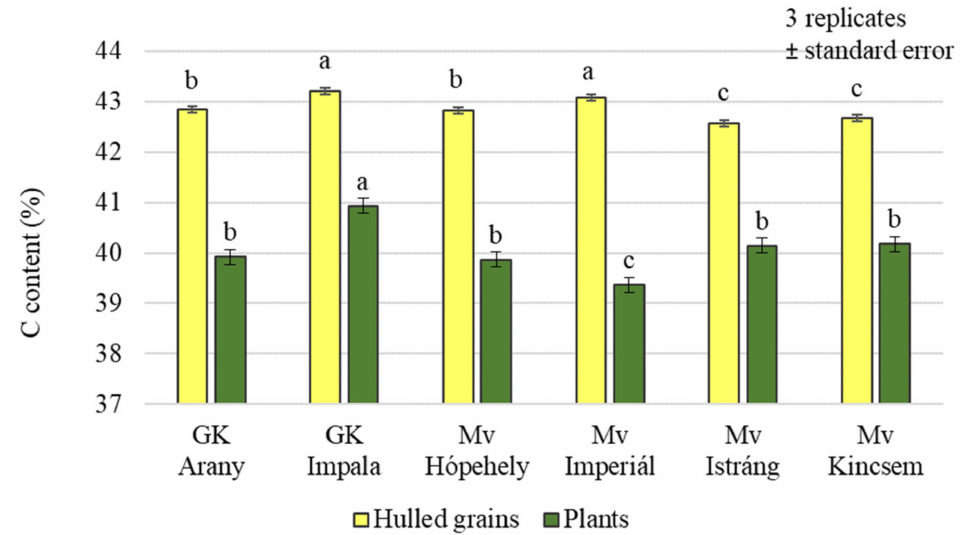
Figure 2. Carbon content of the winter oat varieties (plants, whole and hulled grains); ± standard error of means. 3 replicates. The different letters show significant difference between the varieties, at p = 0.05 level.